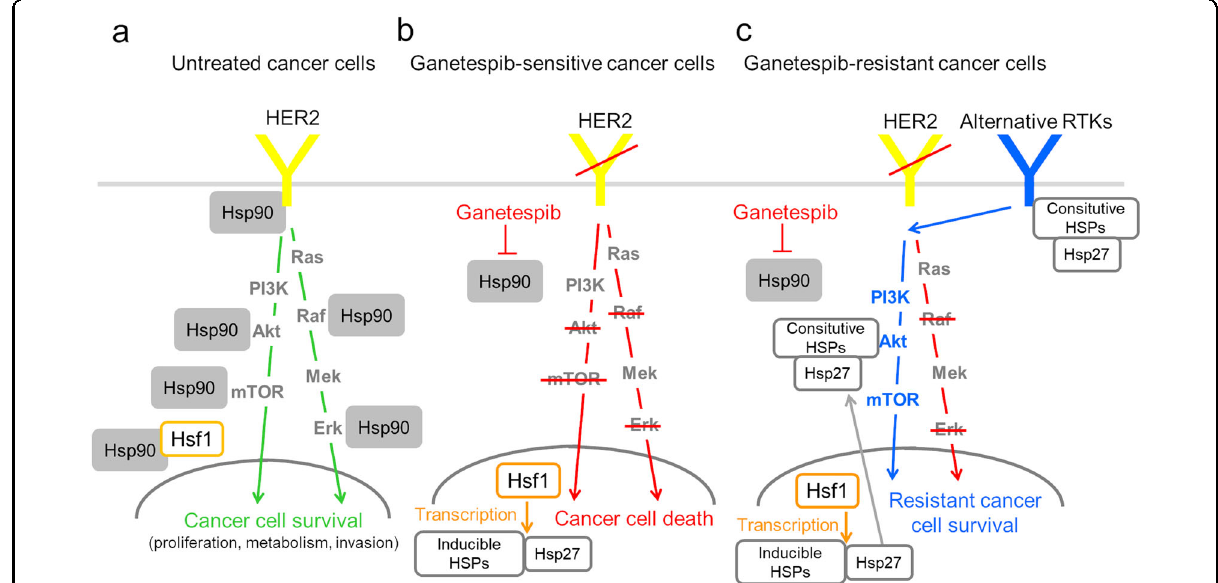
Fig. 5 The proposed mechanism of acquired Ganetespib resistance in HER2-positive breast cancer. a In untreated HER2-positive breast cancer, HER2 and its signaling effectors, supported by the Hsp90 chaperone, promote the survival of cancer cells. b In the HER2-positive breast cancer cells sensitive to Ganetespib, Ganetespib blocks the oncogenic HER2 signaling pathway at multiple levels leading to tumor regression/stagnation. Ganetespib also stimulates the HSF1 transcription factor to activate inducible HSPs, e.g., Hsp27. c In the HER2-positive breast cancer cells resistant to Ganetespib, the upregulated HSPs, in particular Hsp90B, Hsc70 and Hsp27, stabilize multiple compensatory RTKs and their effector Akt/phospho-Akt, leading to tumor survival and growth. Therefore, Akt represents a central actionable node downstream of the HSP/p-RTK resistance program and a therapeutic